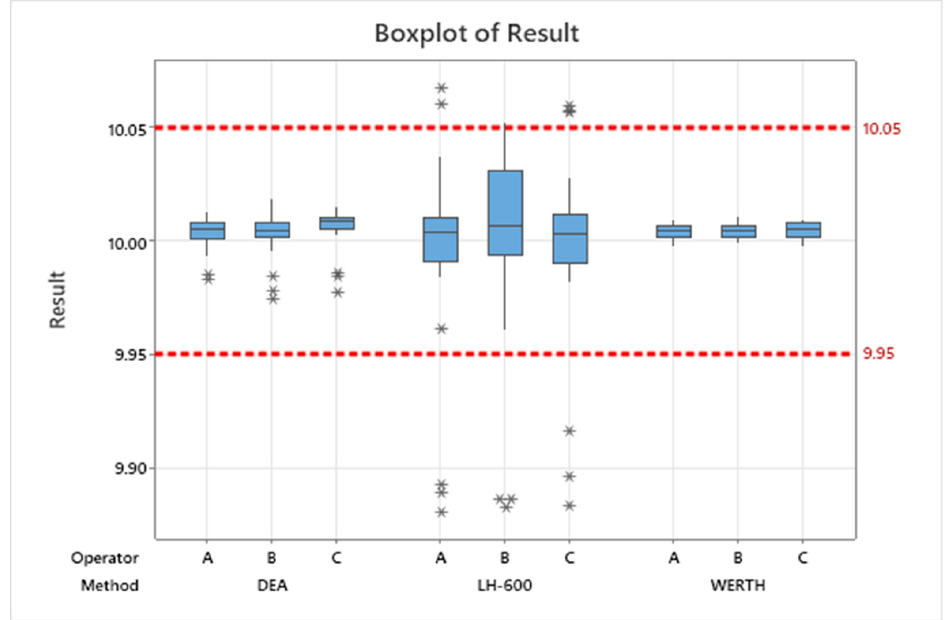
Figure 21. Boxplot chart showing all three measurement systems (own study).